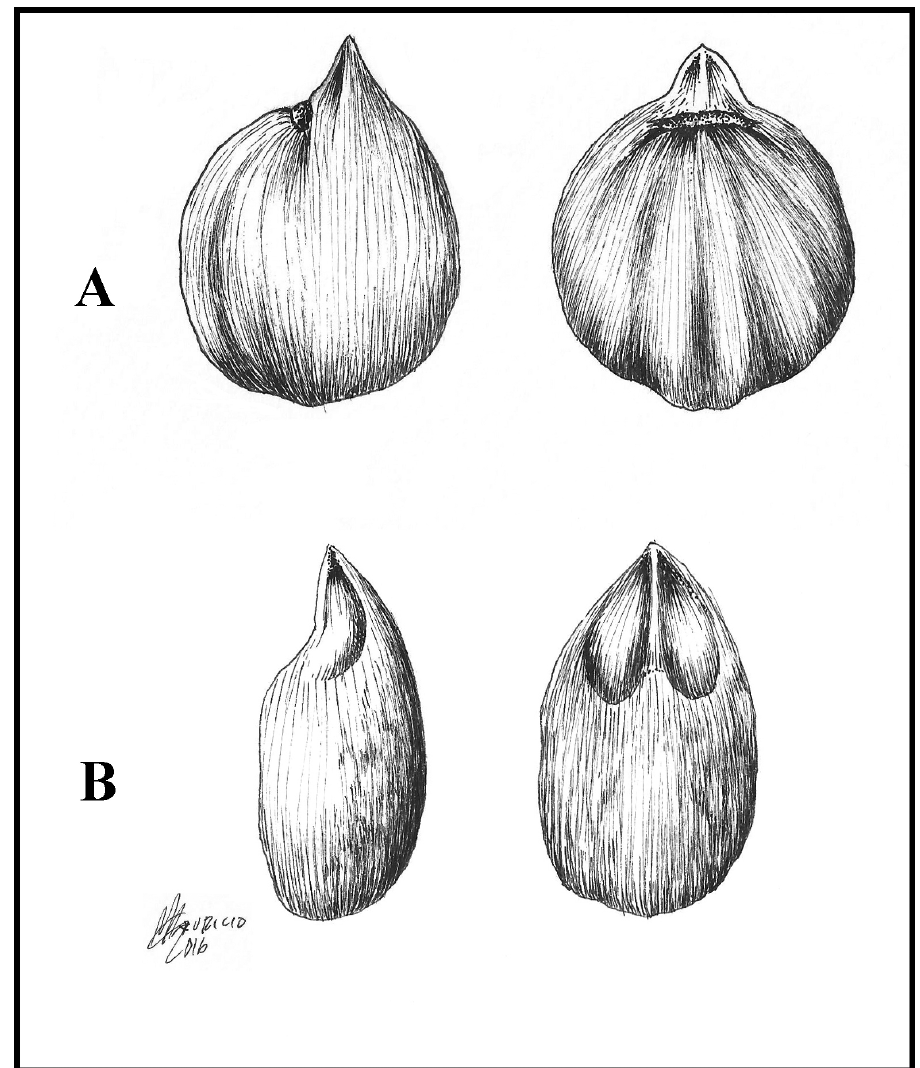
Figure 7. Comparison between the pyrenes of Protium hammelii ( A ) and P. multiramiflorum ( B ). A from G. Davidse & G. Herrera 30879; and B from G.M. Aguilar et al. 4754 . Drawing by Alex M. Campos. Sarapiquí, Southwest trail, 1600 m line, 100 m, 16 Feb 1981 ( ♂ fl), J.P. Folsom 8965 (F, MO); Finca La Selva, the OTS Field Station on the río Puerto Viejo just E of its junction with the río Sarapiquí, central trail to Holdridge Trail 3000 m line, 100 m, 08 Mar 1981 (immat fr), J.P. Folsom 9279 (MO); Finca La Selva, the OTS Field Station on the río Puerto Viejo just E of its junction with the Río Sarapiquí, junction South Boundary and Western Boundary, 21 Mar 1981 (immat fr), J.P. Folsom 9435 (CR); Finca La Selva, the OTS Field Station on the río Puerto Viejo just E of its junction with the Río